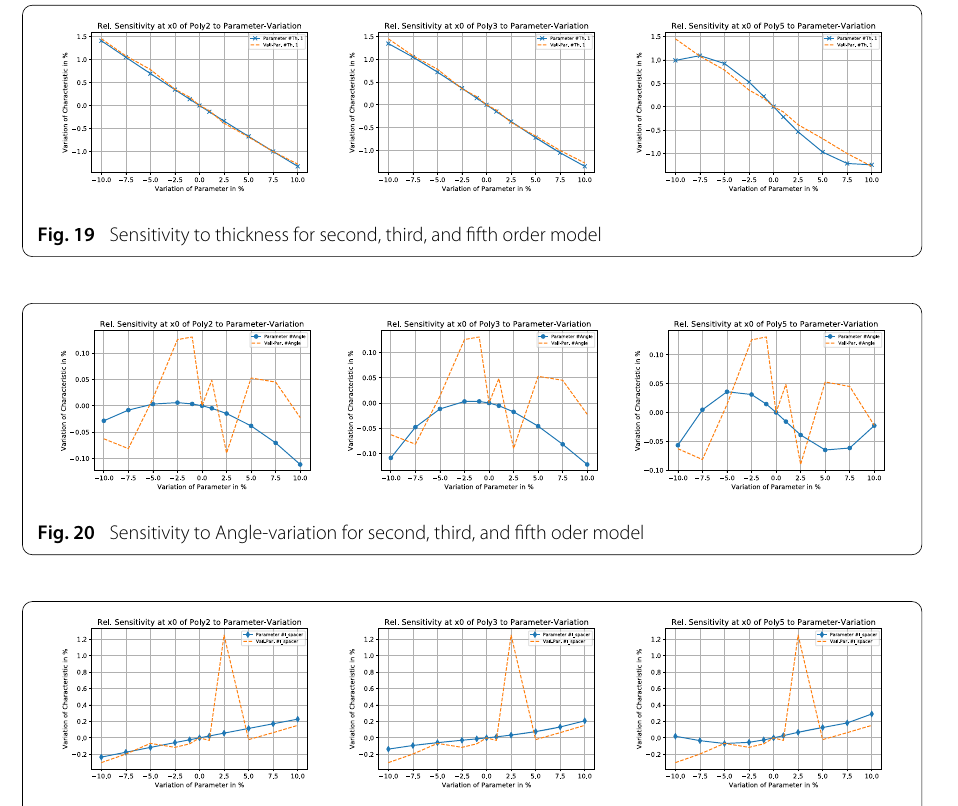
Fig. 21 Sensitivity to spacer length-variation for second, third, and fifth order model